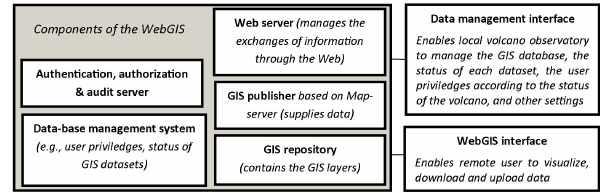
Figure 3. Scheme of the WebGIS application and architecture developed within this study.